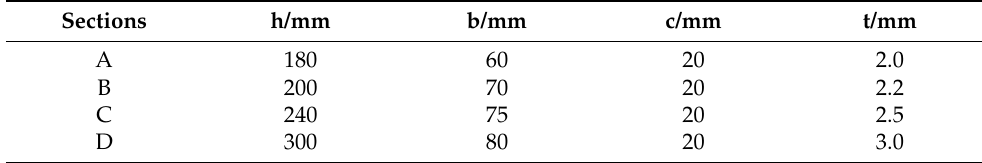
Table 1. Geometric properties of the chosen channel sections.